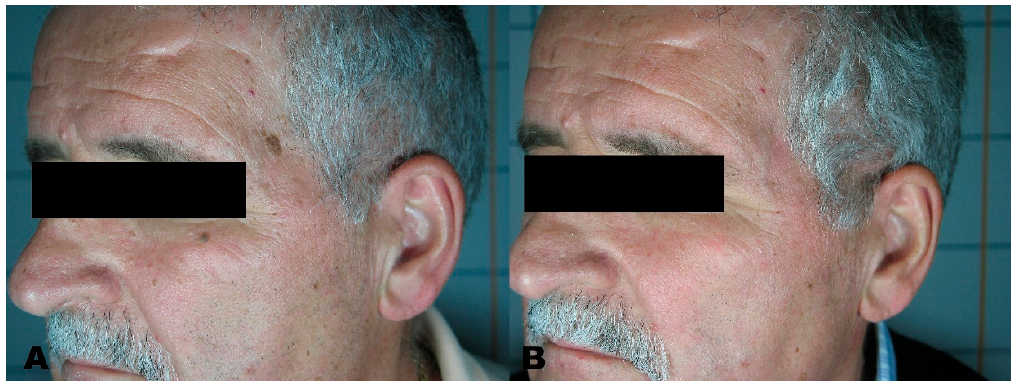
Figure 6. ( A ) Seborrheic keratosis before treatment. ( B ) Region after removal with Erbium laser.